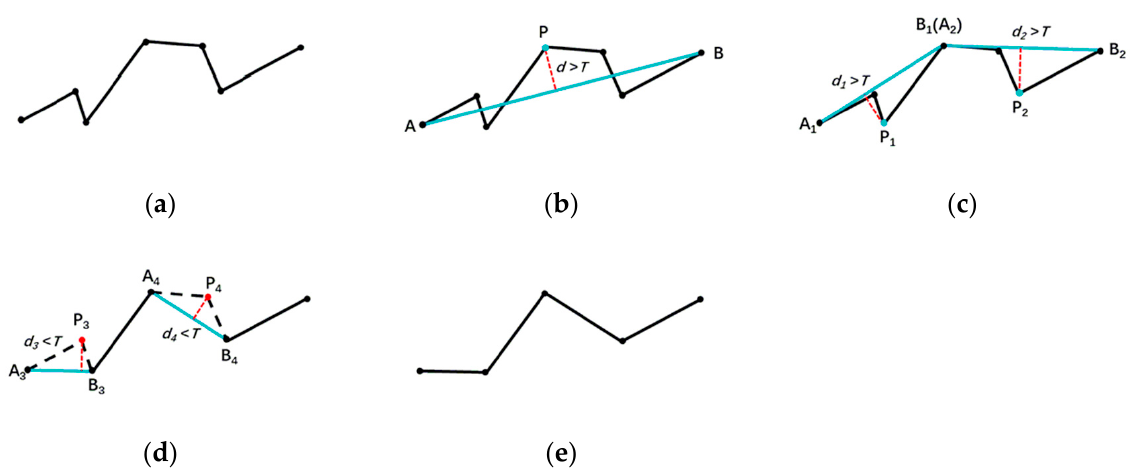
Figure 6. Principle of the Douglas–Peucker algorithm: ( a ) initial polyline; ( b – d ) judgment and processing step by step; ( e ) simplifed result.